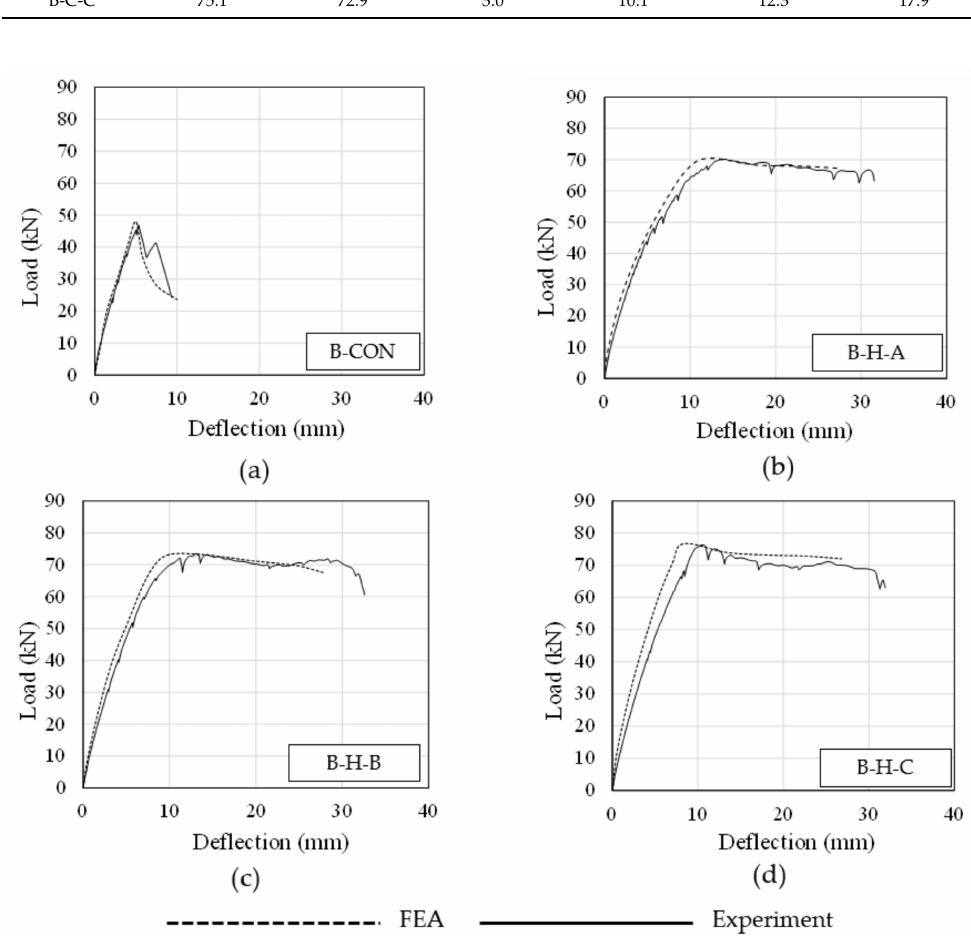
Figure 20. Load deflection curves of control and hemp FRRP composite strengthened beams ( a ) B-CON, ( b ) B-H-A, ( c ) B-H-B, ( d )